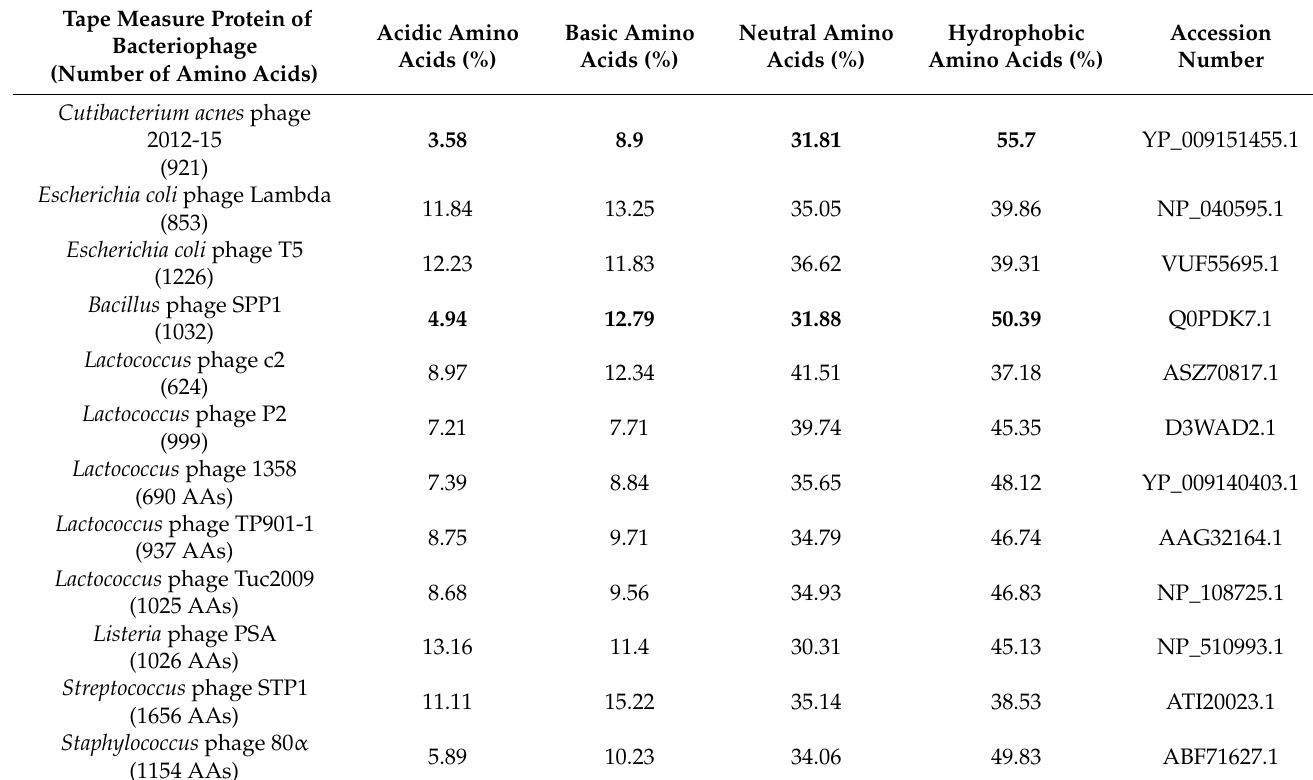
Table 3. Hydrophobicity of the tape measure proteins from 12 Siphoviridae bacteriophages. Bold numbers indicate proteins with more than 50% hydrophobic amino acid composition, which may be insoluble or partially soluble in aqueous solutions. AAs: amino acids.